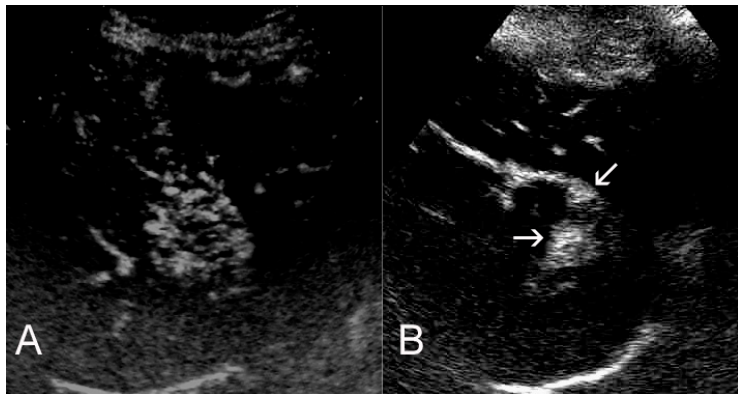
Figure 2. CEUS diagnosis of partial response post ablation. CEUS images of a hypervascular HCC at baseline (A), and one month post ablation (B). At baseline, the tumor shows intense, early enhancement. Post ablation, a nodular residual tumor, also exhibiting strong, early enhancement, is noted